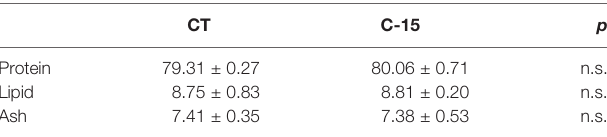
TABLE 4 | Muscle proximate composition (% dry weight) of juvenile C. labrosus fed control (CT) and C-15 diets during 90